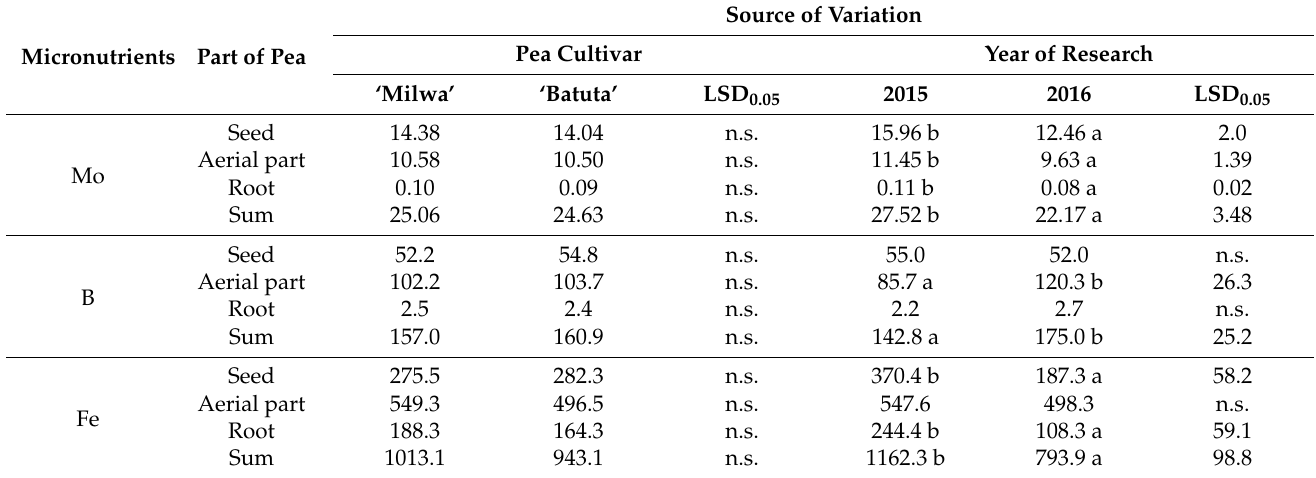
Table 6. Mo, B, and Fe uptake by pea at BBCH stage 90, g · ha − 1 dm.